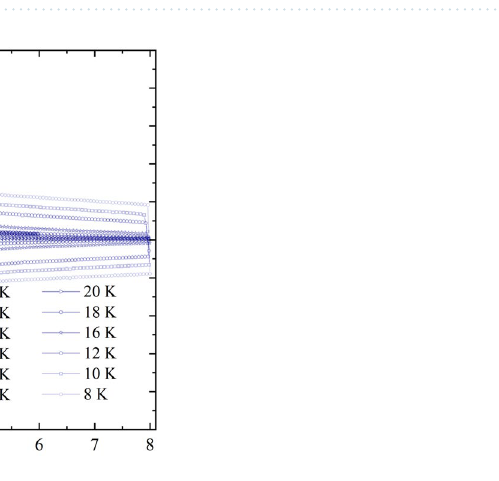
Figure 2. ( a ) J C and J E and ( b ) n values from V–I curves ( V = v o I at different temperatures.